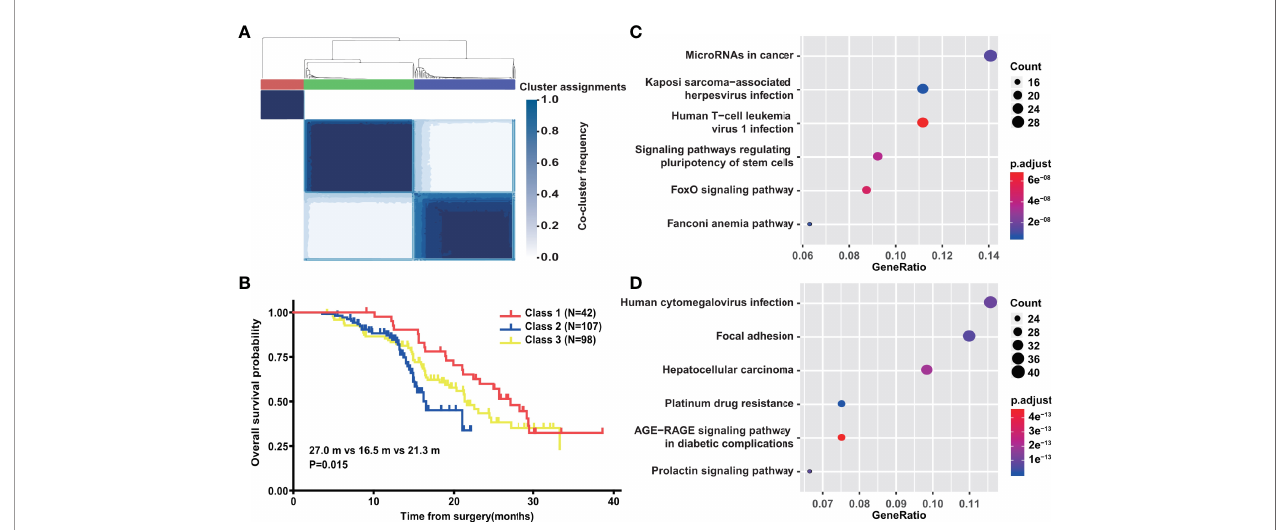
FIGURE 6 | Network-based strati fi cation of PDAC with genetic mutation. (A) Schematic of network-based strati fi cation in above 247 PDAC (n = 247). (B) Overall survival analysis of above 247 PDAC patients classi fi ed by network-based strati fi cation. (C) The differential KEGG signal pathways among top 30 signi fi cantly enriched in class 1. (D) The differential KEGG signal pathways among top 30 signi fi cantly enriched in class